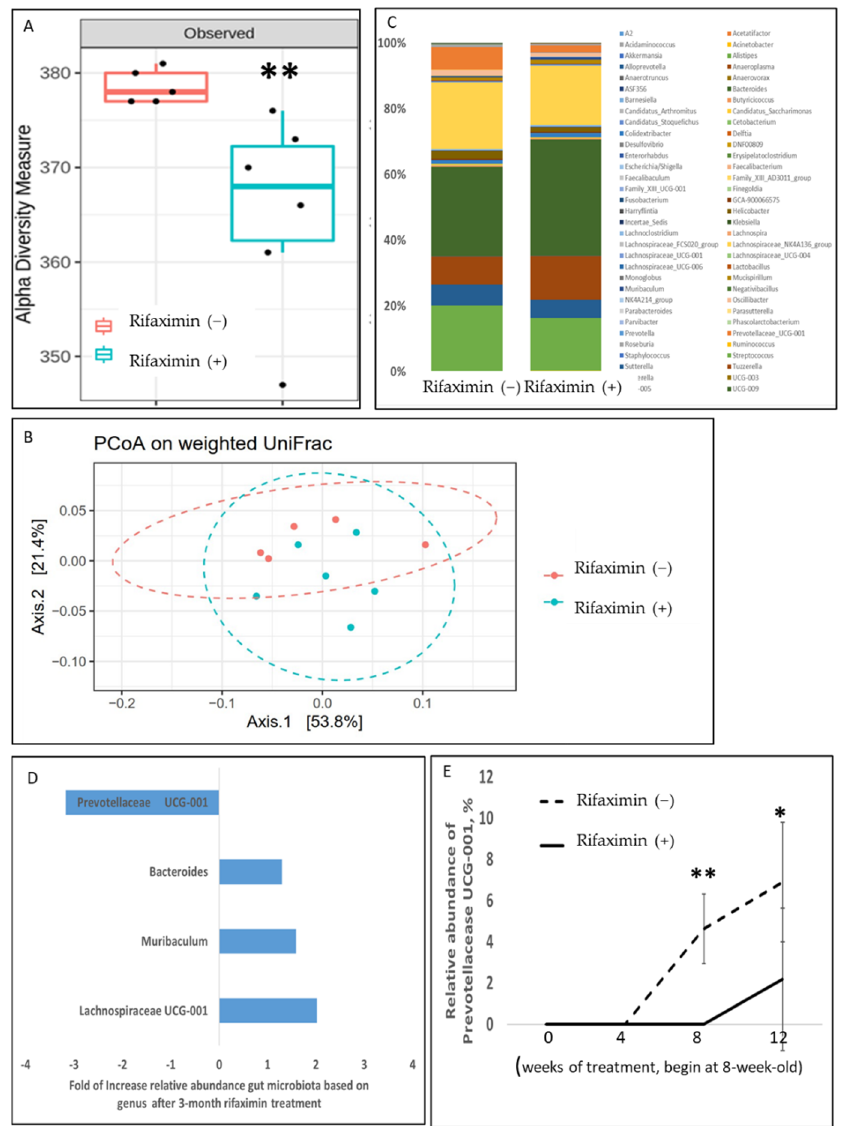
Figure 1. Effect of rifaximin treatment on the alteration of gut microbiota in MitoPark mice. The stool samples of the MitoPark mice that were or were not treated with rifaximin were prepared for fecal microbiome profiling through the high-throughput sequencing of the 16S rRNA gene by using the Illumina MiSeq system. ( A ) Alpha diversity of the rifaximin-treated samples and nontreated controls after 3-month treatment. ( B ) A weighted principal coordinate analysis (PCoA) plot based on the UniFrac distances of the rifaximin-treated samples and nontreated controls after 3-month treatment. ( C ) The taxonomic analysis of GM revealed the relative abundance of bacterial genera in the MitoPark mice that were or were not treated with rifaximin over 3 months. ( D ) Differences in the relative abundance of bacteria genera between the MitoPark mice that were or were not treated with rifaximin. ( E ) Changes in the relative abundance of Prevotellaceae UCG-001 in the MitoPark mice that were or were not treated with rifaximin during experiments. Data are presented as mean ± standard deviation. *, p < 0.05, **, p < 0.01.